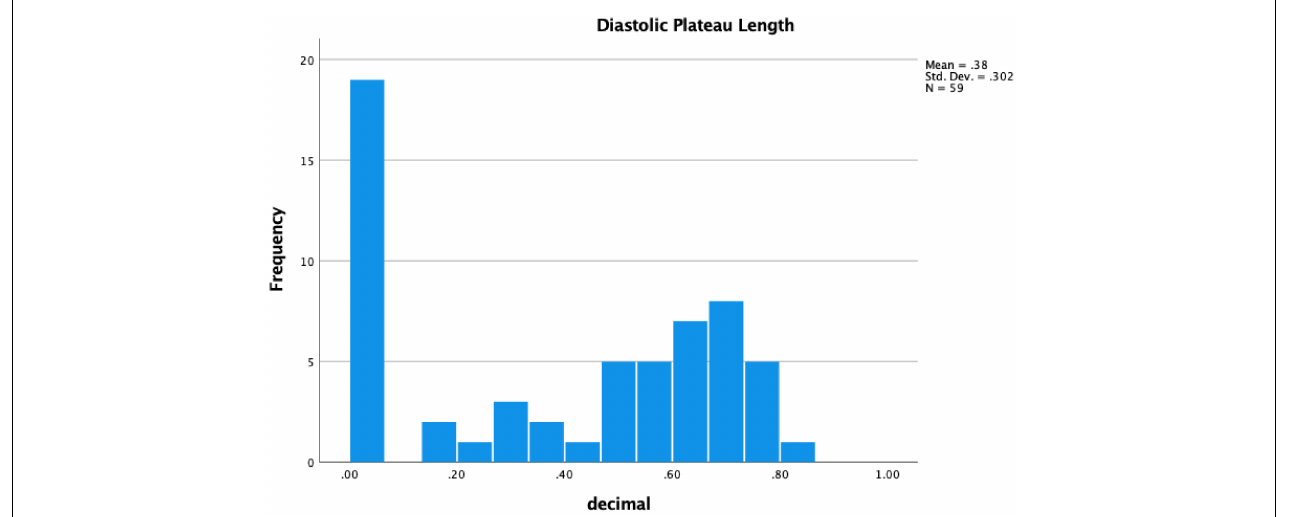
FIGURE 2 | Diastolic plateau distribution.